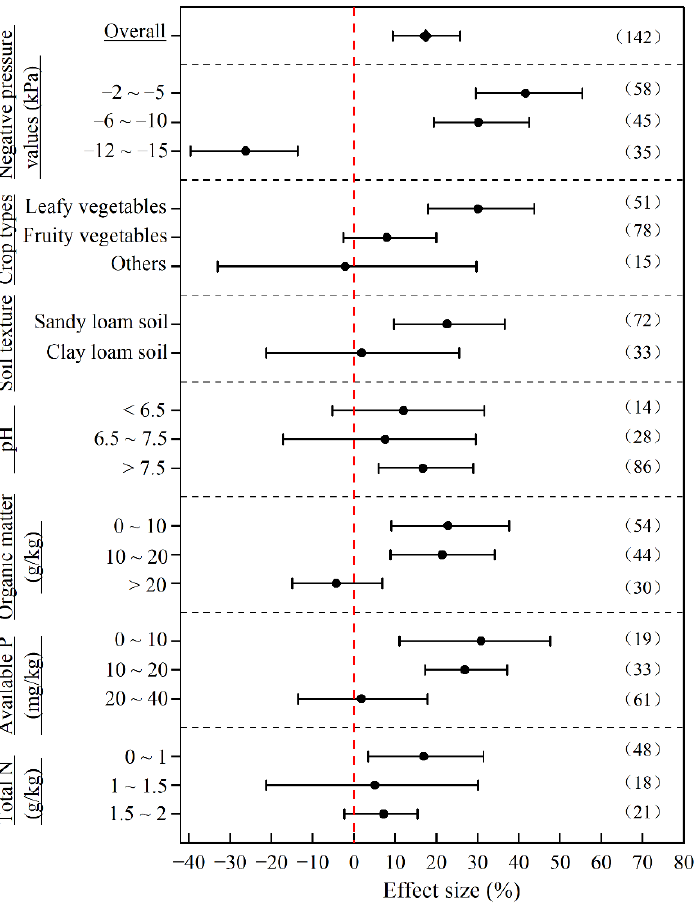
Figure 2. Effect size analysis of various factors on crop yields under negative pressure irrigation compared with conventional irrigation conditions. P, phosphorus; N, nitrogen.